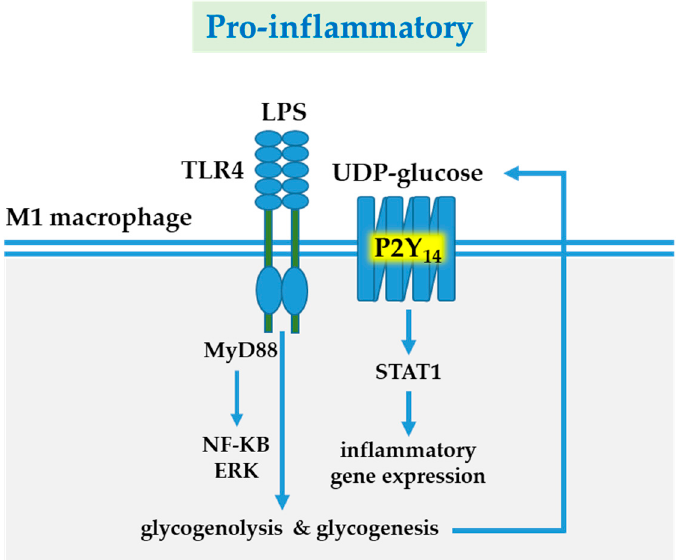
Figure 3. P2Y 14 receptor-mediated pro-inflammatory responses. LPS-induced TLR4 signaling via MyD88/NF-KB/ERK is a major pathway of macrophage activation. In inflammatory M1 macrophages, LPS/IFN γ -enhanced glycogen metabolism (synthesis and lysis) causes accumulation and release of UDP-glucose, resulting in P2Y 14 receptor activation. P2Y 14 receptor signaling upregulates expression and phosphorylation of STAT1. Abbreviations: extracellular signal-regulated kinase (ERK); IFN, interferon; LPS, lipopolysaccharide; nuclear factor kappa- Β ; MyD88 (myleoid differentiation primary-response protein 88); STAT1, signal transducer and activator of transcription 1; TLR, Toll-like receptor; UDP, uridine diphosphate.